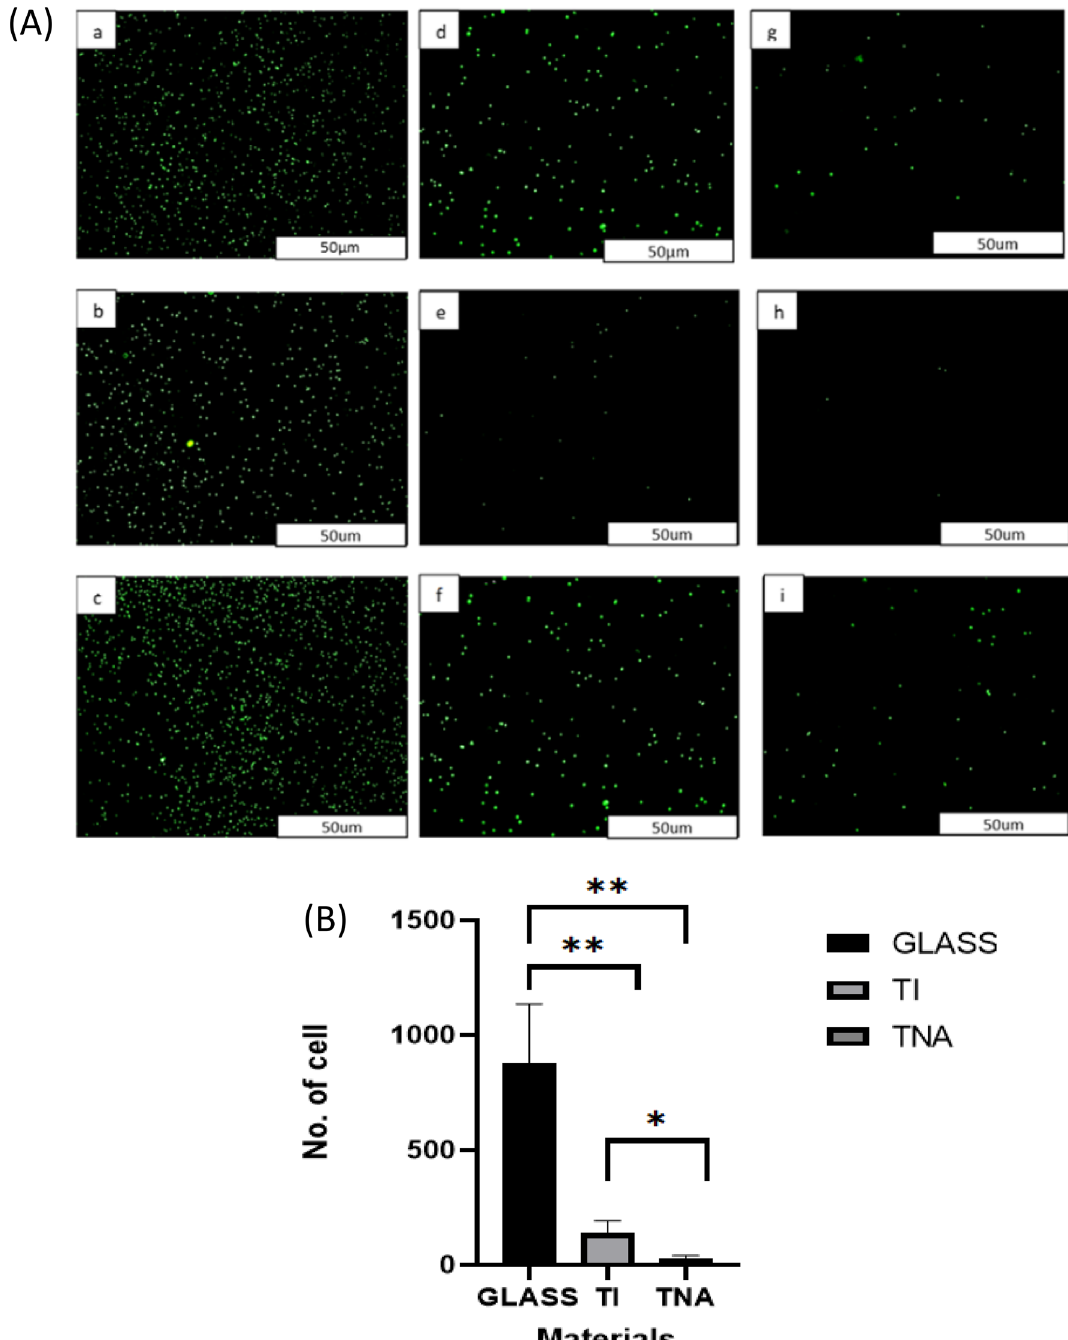
Fig. 6 Platelet adhesion profile using fluorescence microscopy analysis on glass, Ti alloy, and TNA nanosurfaces. A The green signals represent the presence of adhered live cells (platelets and leukocytes) stained with calcein-AM staining. The image of ( a – c ) displayed observation on glass surface, ( d – f ) on the Ti surface, and ( g – i ) is on the TNA surface. Experiment were done in triplicate. B Quantitative data on the number of cells covered by the adhered cells on the surface using ImageJ software. The result shows significantly lower cell adhesion on TNA nanosurface when compared to glass ( p 0.0047) and Ti alloy ( p 0.0218). The error bar represents the standard = =